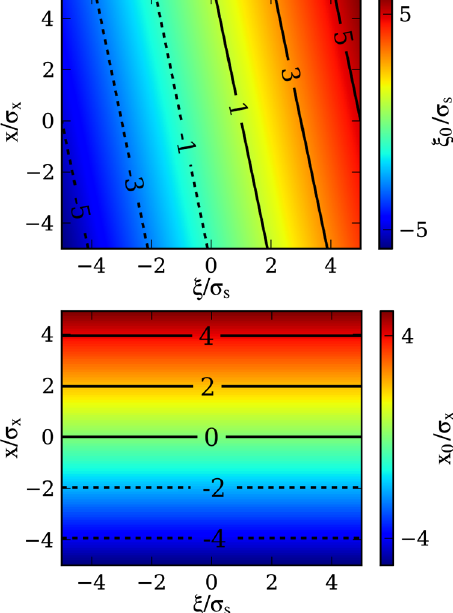
Þ transform for the parameters in ; x FIG. 14. ð (cid:13); x Þ ! ð (cid:13) 0 0 ¼ (cid:16) ¼ 200 (cid:14) m , (cid:2) ¼ 100 , and R ¼ 100 cm , Fig. 9, i.e., (cid:16) x s when the beam has rotated (cid:7) ¼ 10 (cid:10) (cid:9) 0 : 175 rad . The major ð (cid:13); x Þ where (cid:13) has effect of the transform is seen in the plot of (cid:13) 0 0 a x -dependent shift to (cid:13) .